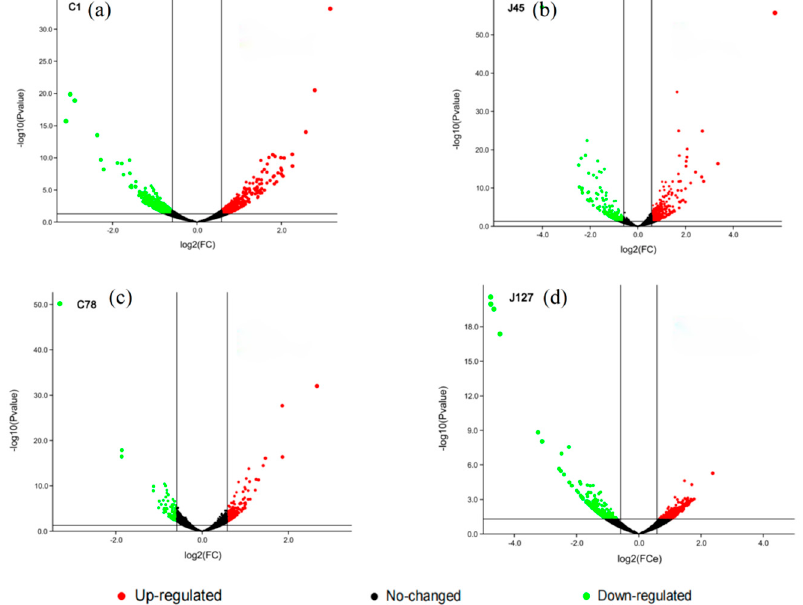
Figure 5. Volcano map of candidate genes induced by 2 mg/L Cd. Volcano map shows the DEGs in four selected C. geophilum strains after 2 mg/L Cd treatment as compared to the same strains cultured in normal conditions (0 mg/L Cd). Red spot indicates significant up-regulated genes after cadmium treatment; green spot indicates significantly down-regulated genes; black spot indicates no-change genes. |log2Foldchange| ≥ 2 was used as the screening criteria of DEGs.